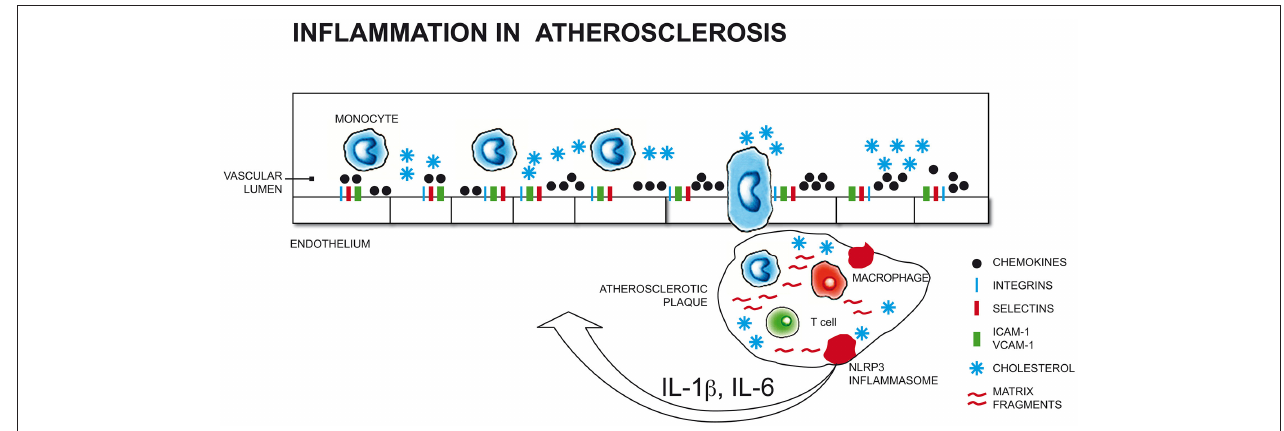
FIGURE 1 | Pathological conditions that include common cardiovascular risk factors (such as hypertension, hyperlipidaemia, hyperglycaemia, smoking) and stress-related conditions (i.e. depression, anxiety) can elicit immune responses that promote the secretion of leukocyte adhesion molecules and chemotactic factors, inducing monocyte adhesion to endothelial cells and transmigration into the subintimal space. Initial atherosclerotic lesions begin with the differentiation of monocytes into macrophages that engulf cholesterol-rich oxidized lipoproteins to become foam cells that organize into fatty streaks. The perpetuation of pro-inflammatory and oxidizing atherosclerotic stimuli results in the recruitment of further macrophages, mast cells, and activated T and B cells that increase vascular lesions, which, in turn, releasing cytokines (i.e., IL-1 β , TNF- α ), increases monocytes migration into the subintimal space (17–20). ICAM-1, Intercellular Adhesion Molecule 1; VCAM-1, Vascular cell adhesion protein 1; NLRP3, nucleotide-binding domain and leucine-rich repeat containing (NLR) family member pyrin domain-containing protein 3; IL-1 β , Interleukin 1 beta; IL-6, Interleukin